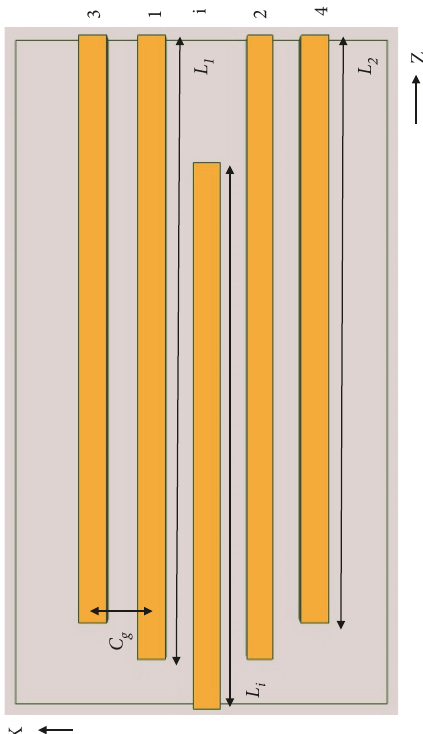
Figure 2: The schematic structure of the proposed four-branch optical power splitter in 𝑥 − 𝑧